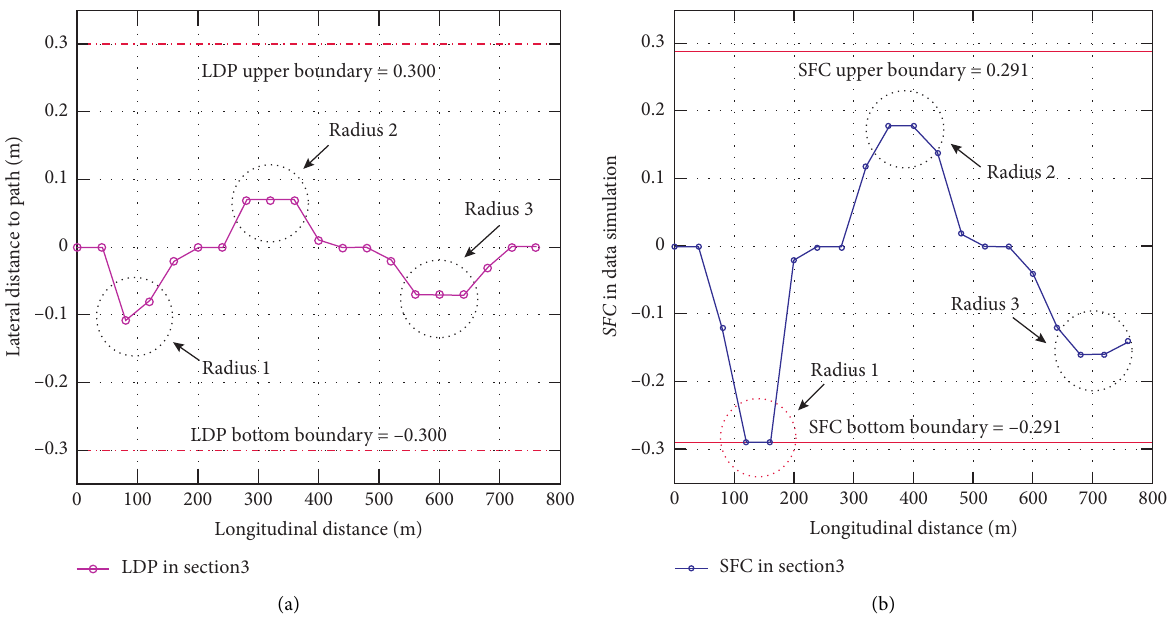
Figure 10: The simulation results of section 3. (a) Lateral Distance Path Change Trend. (b) SFC Change